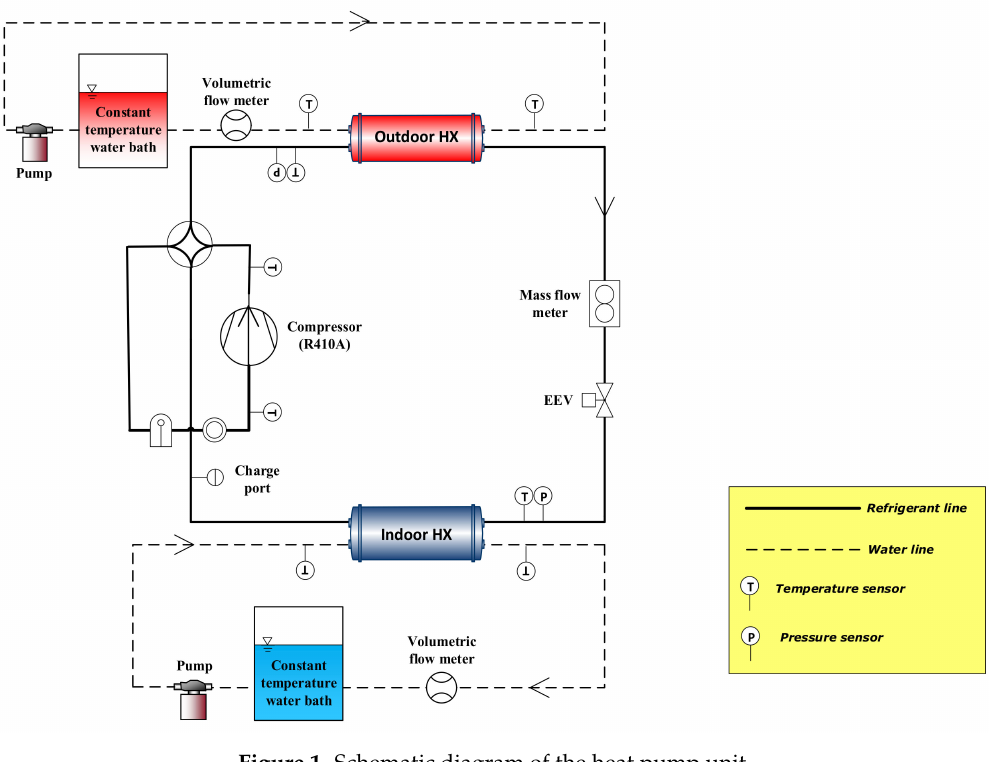
Figure 1. Schematic diagram of the heat pump unit.